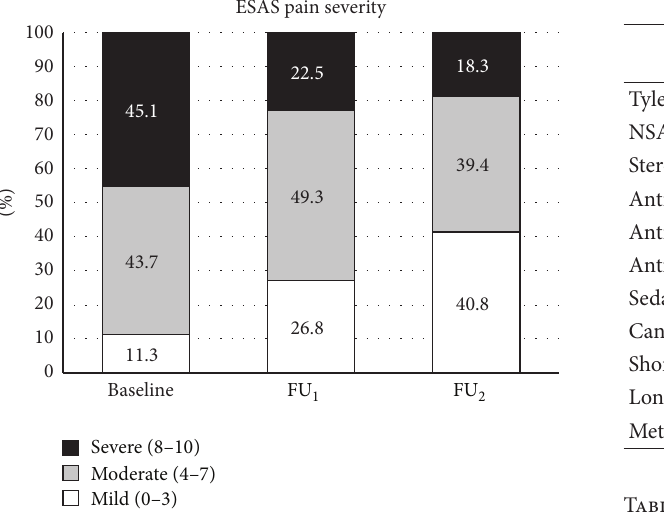
Figure 2: Distribution of patients by pain categories.